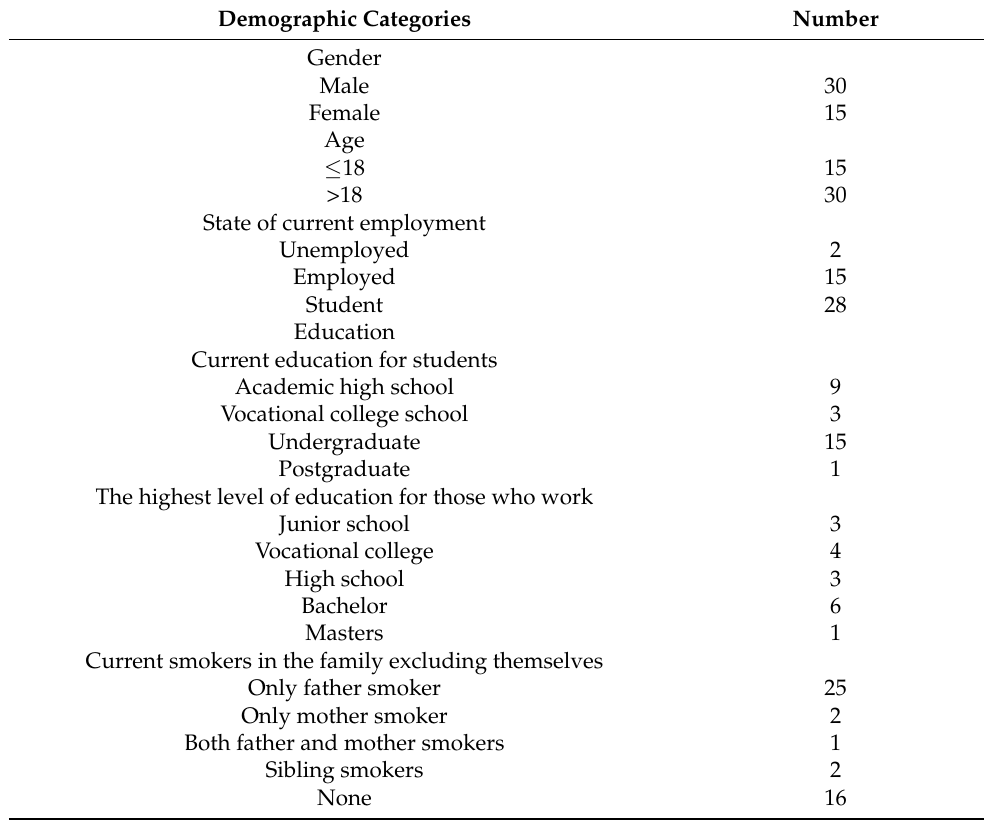
Table 1. The demographic characteristics of the 45 interview